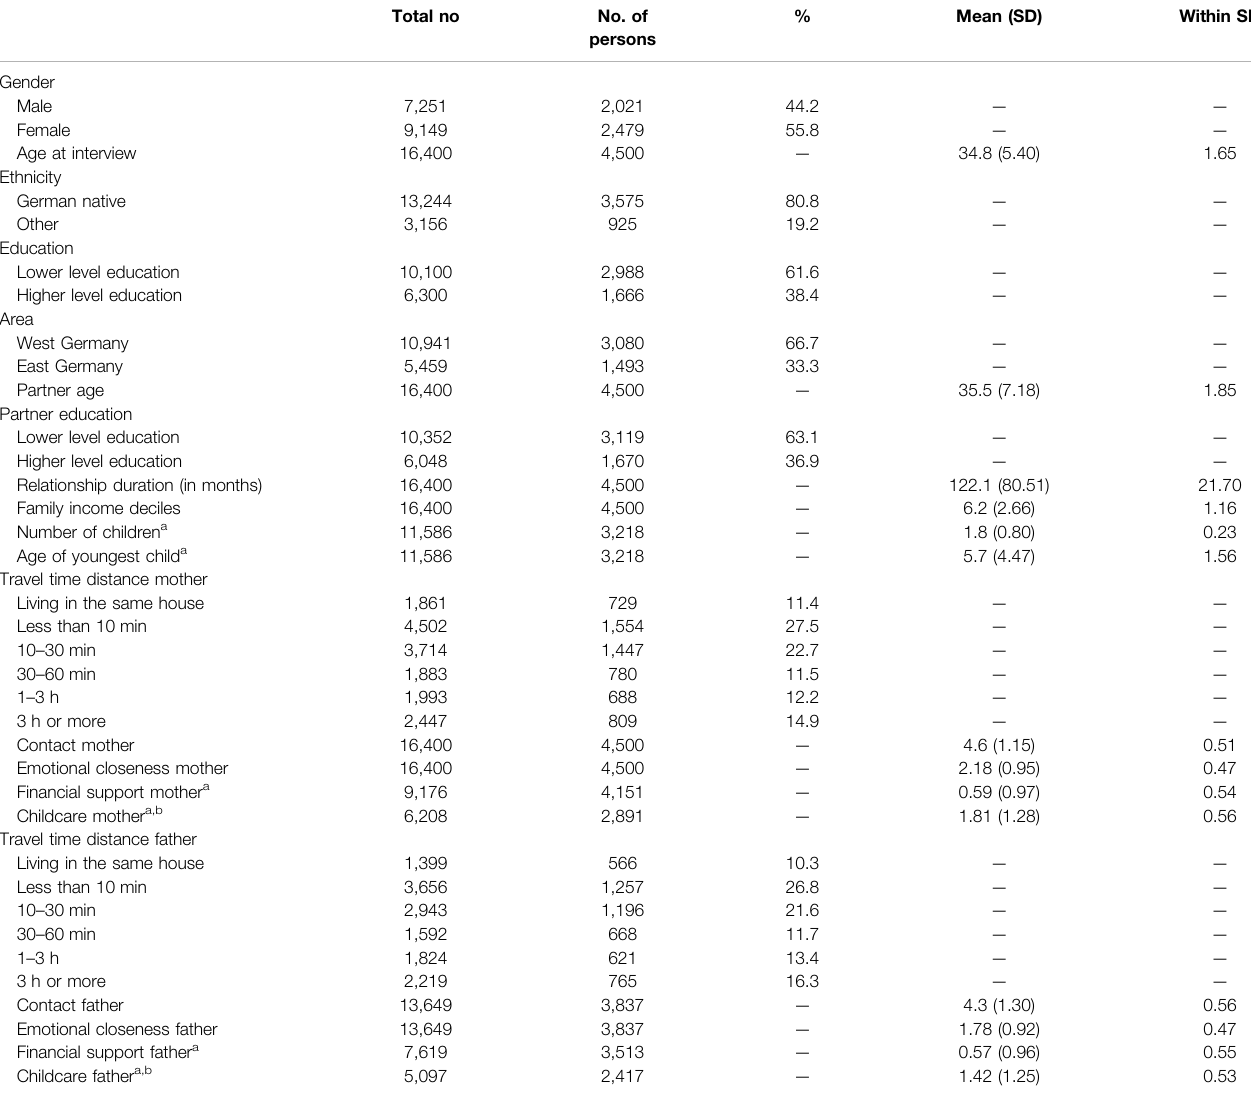
TABLE 1 | Descriptive statistics over waves 1-8 in the